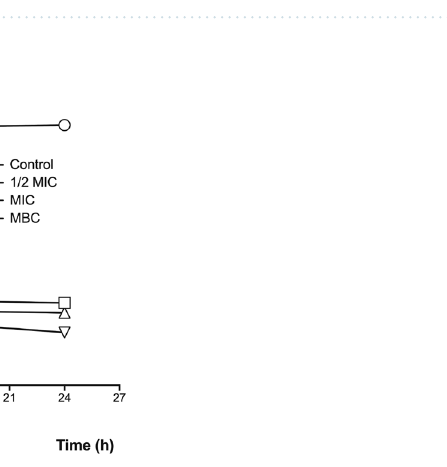
Figure 2. Activity of the P. laevigata methanolic leaf extract against some filamentous fungi: ( a ) Fusarium sporotrichioides ATCC NRLL3299, ( b ) Fusarium moniliforme CDBB-H-265, ( c ) Fusarium oxysporum , ( d ) Fusarium sp., and ( e ) Fusarium subglutinans .